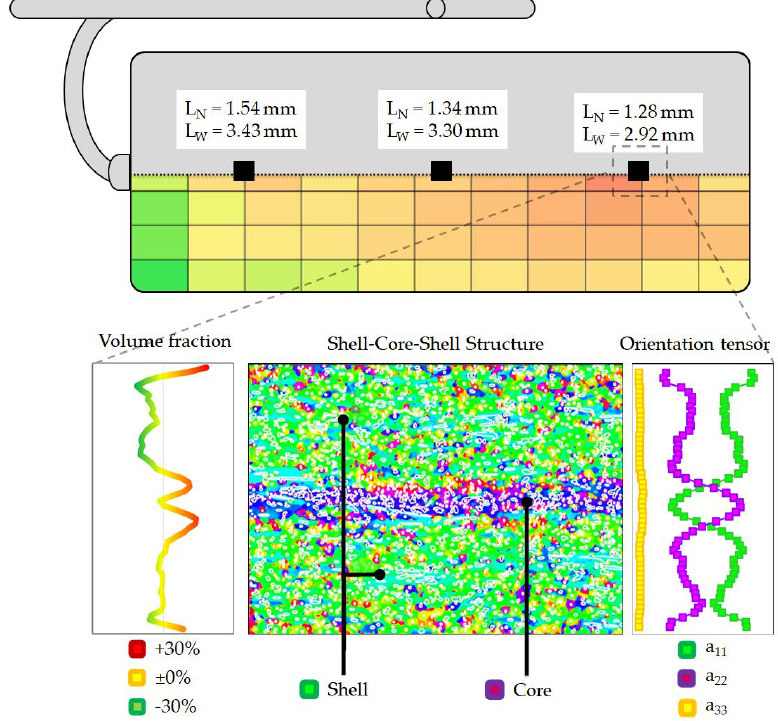
Figure 4. Fully characterized microstructure of an injection molded plaque.